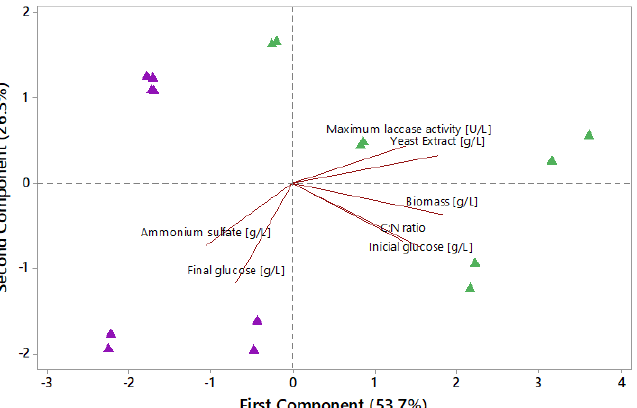
Figure 2. Principal component analysis (PCA) of biological parameters of growth of P. ostreatus in culture media with ammonium sulfate or yeast extract in SmF. The purple triangles represent culture media with ammonium sulfate and the green triangles media with yeast extract.